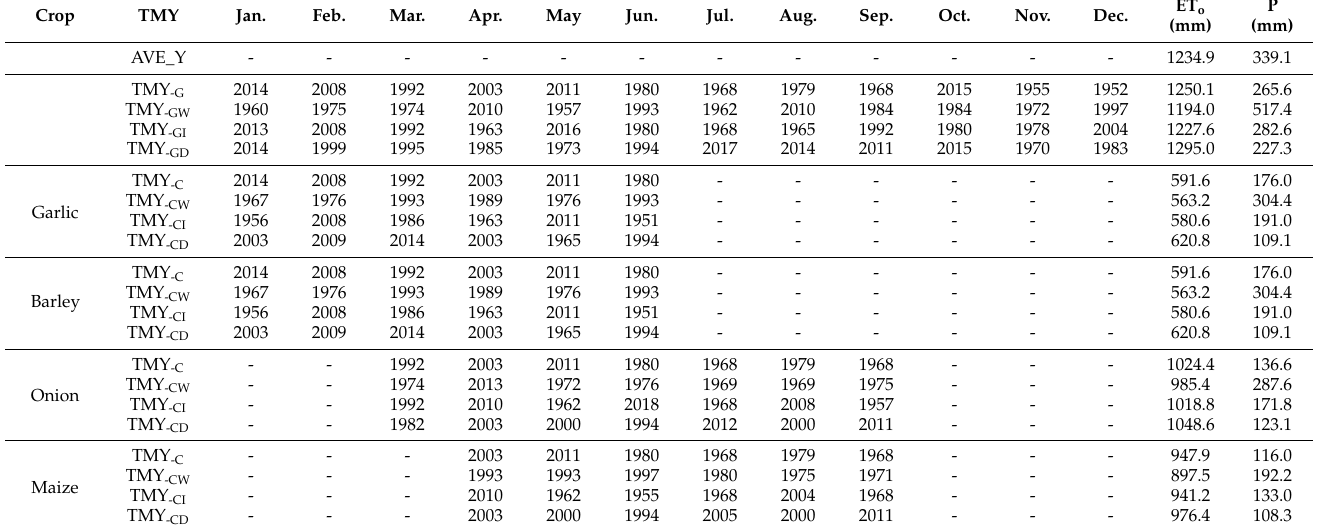
Table 3. Years comprising each typical year by using the 1951–2020 series, and the total accumulated reference evapotranspiration (ET o ) and rainfall (P) for the growing period